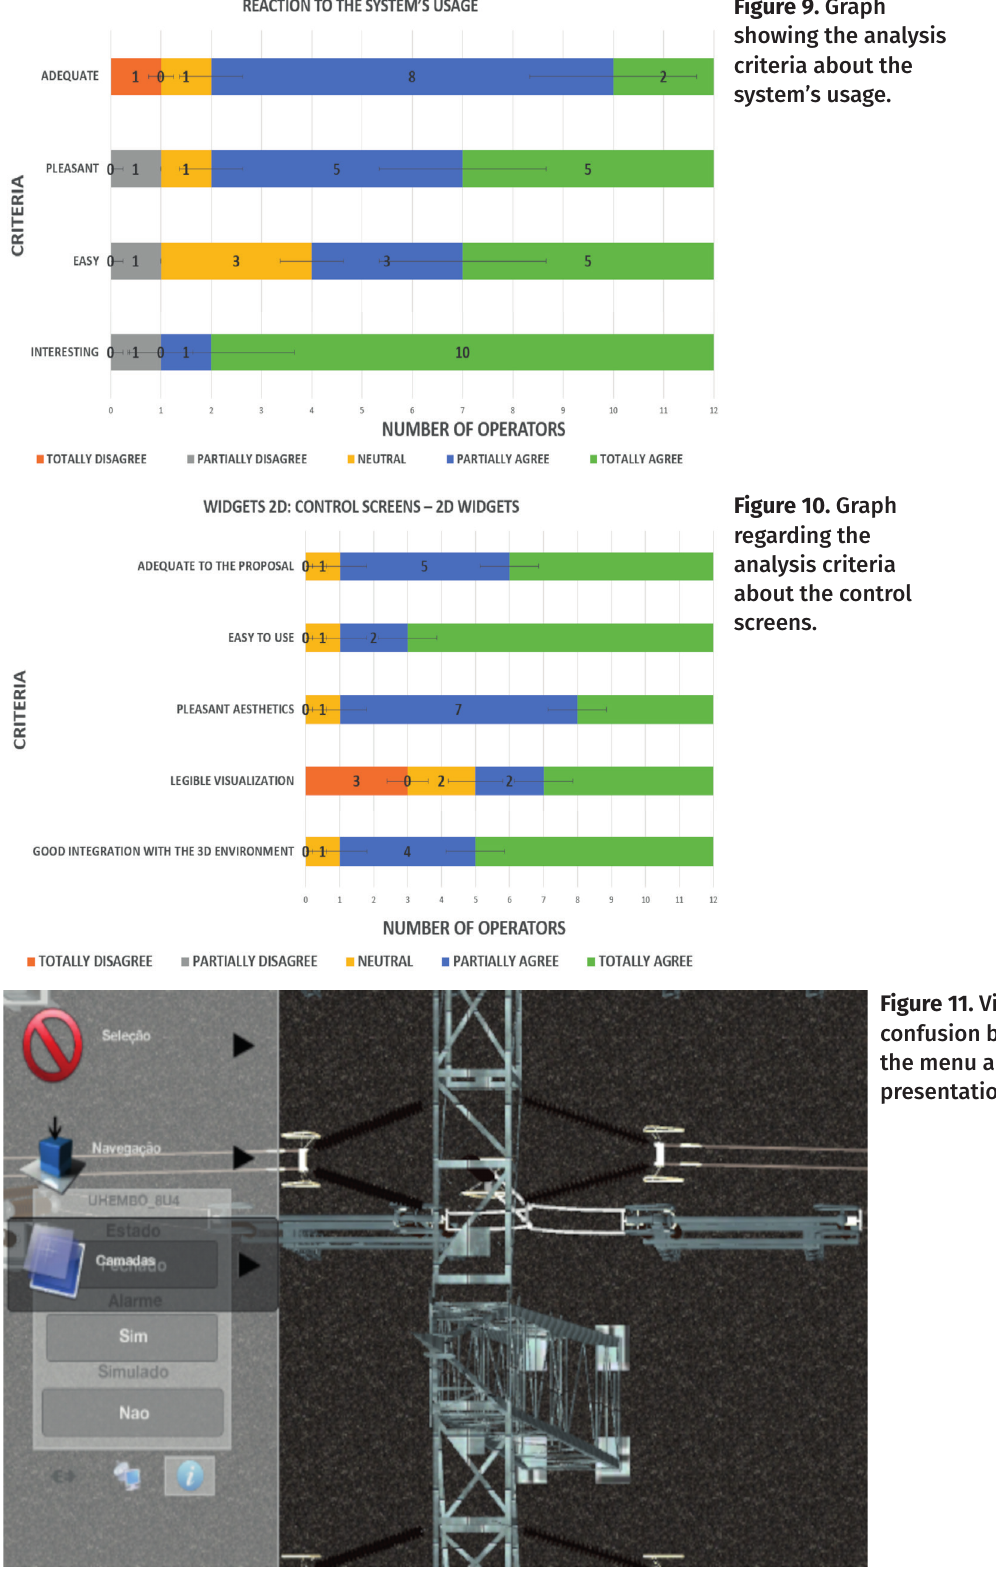
Figure 9. Graph showing the analysis criteria about the system’s usage.